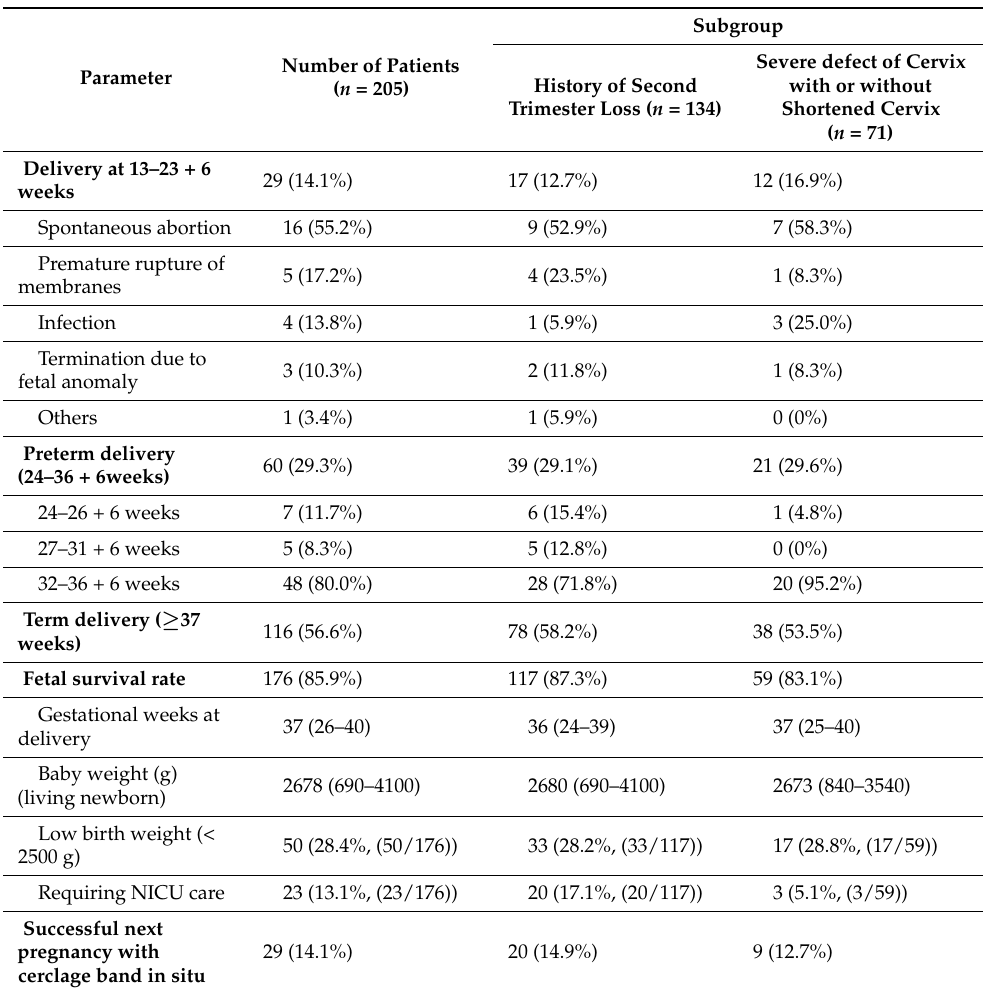
Table 3. Obstetrics outcomes of modified